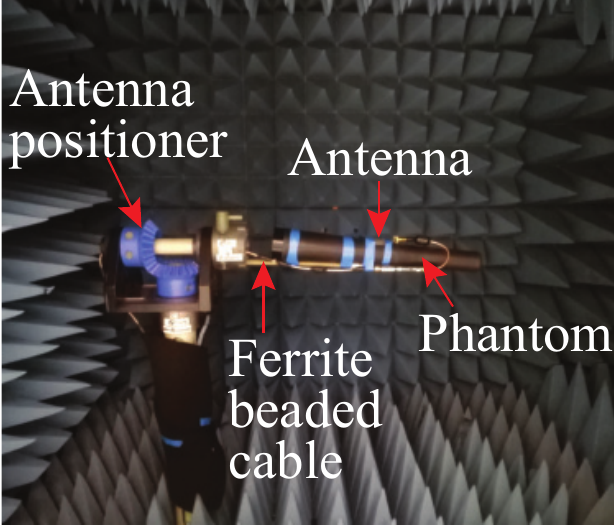
Figure 23. Antenna measurement set-up inside the AMS-8050 Antenna Measurement